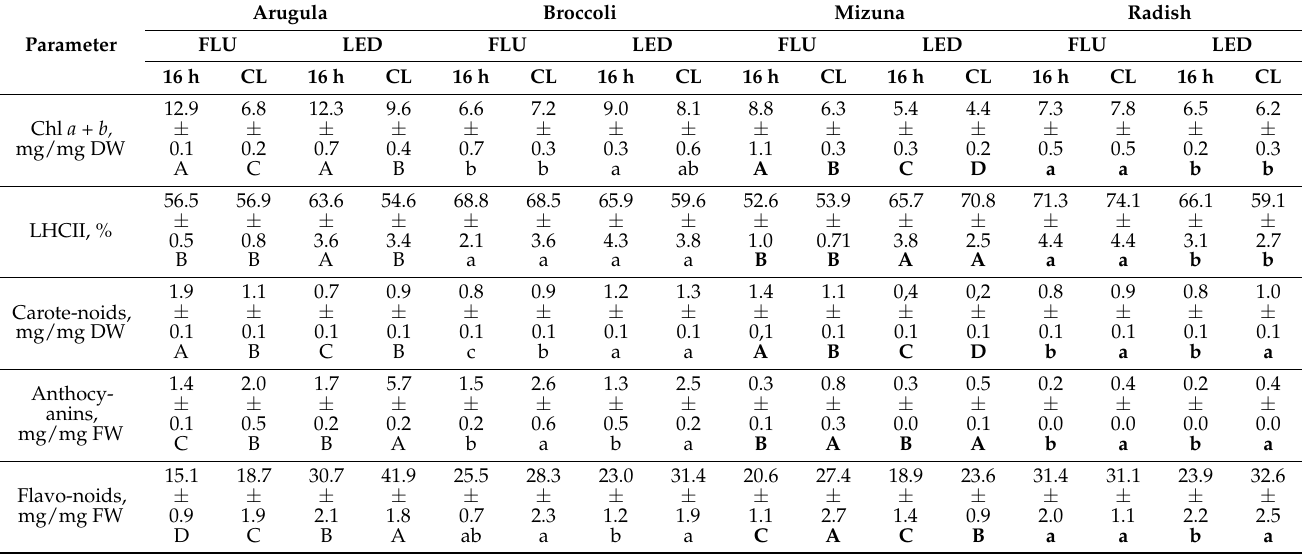
Different letters for each plant species indicate significant differences between the mean values at p <